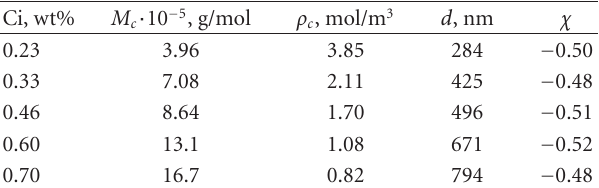
Table 2: E ff ect of changes in Ci on primary structural parameters of PAA